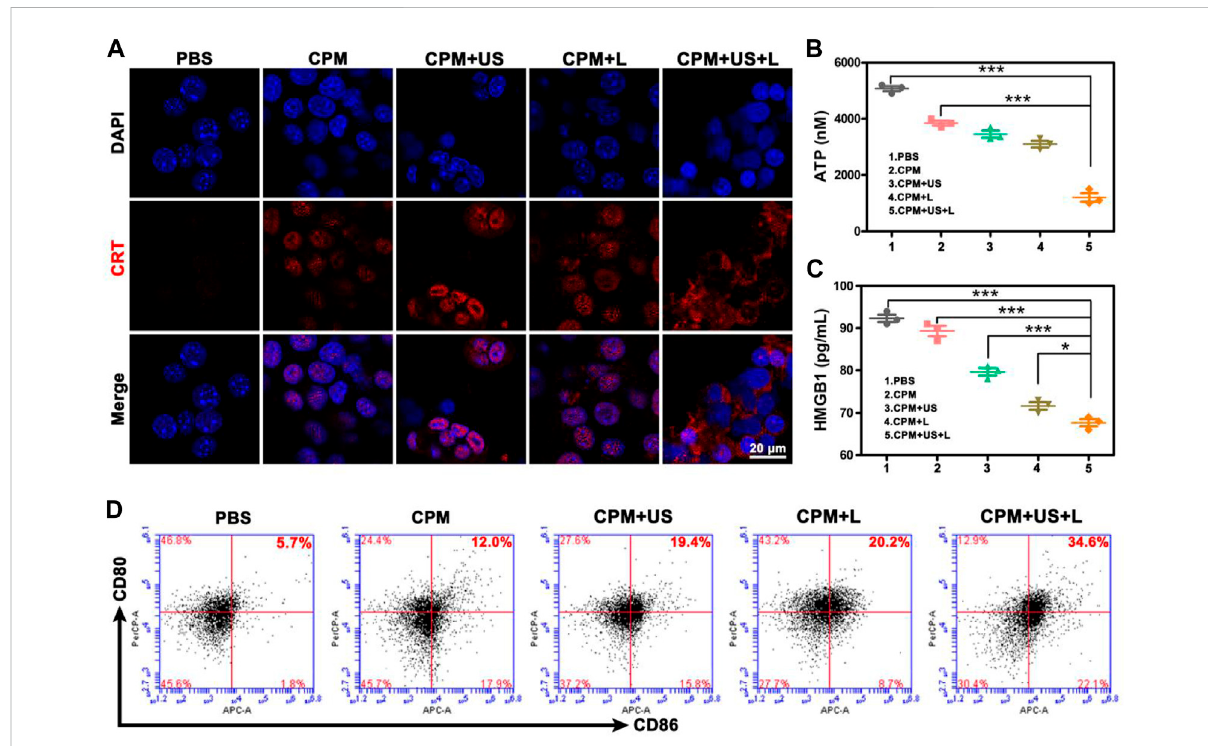
FIGURE 5 (A) CRT exposure. (B) Intracellular ATP and (C) HMGB1 release from 4T1 cells after various treatments. Data are means ± SD, * p < 0.05, ** p < 0.01, and *** p < 0.001. (D) Flow cytometry analysis of the expression of CD80 + /CD86 + DC cells (markers for maturation) on the surface of DCs after various